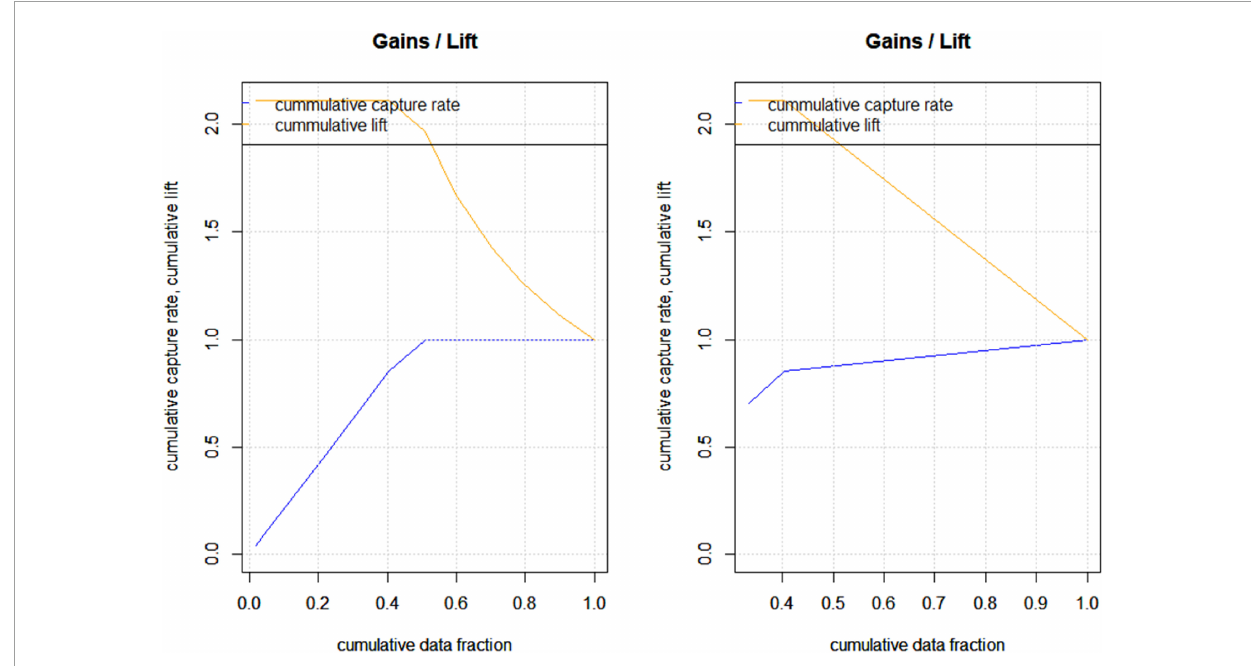
FIGURE9 The gain and lift chart for explaining the performance of the model on the testing datasets for (A) DNN and (B) RF models.